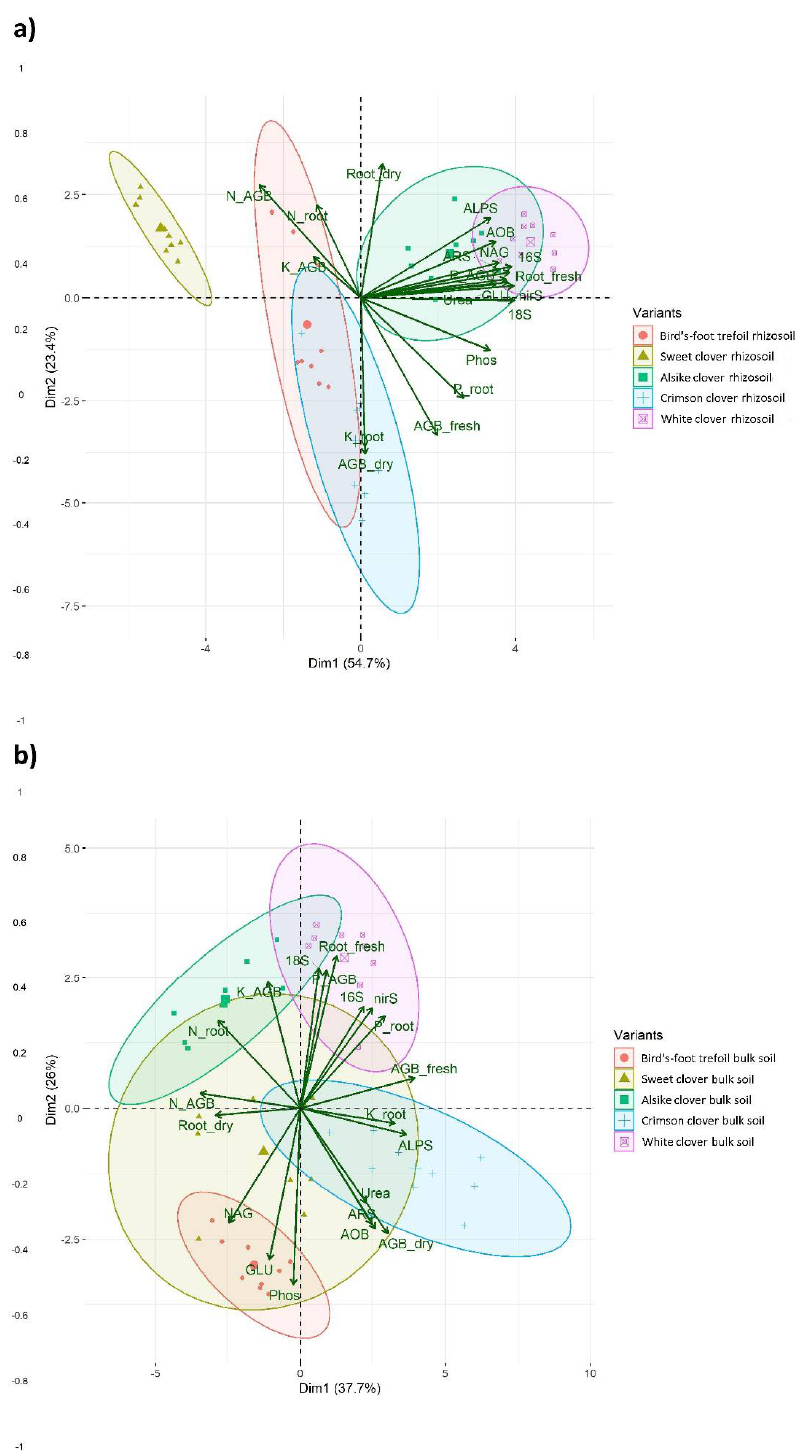
Figure A1. PCA biplot analyses of the properties of rhizosoil ( a ) and bulk soil ( b ) and plant biomass. Abbreviations are: (AGB-fresh, dry); fresh and dry aboveground biomass, (root-fresh, dry); fresh and dry root biomass, (N-, P-, K- AGB or root); biomass nutrient (N,P,K) in AGB or roots, (16S, 18S, AOB, NirS , ALPS); bacterial, fungal, ammonium oxidizing bacteria, denitrifying bacteria and phosphorus solubilizing bacteria and (Glu, ARS, Phos, NAG, Ure); β -glucosidase, arylsulfatase, phosphatase, N-acetyl- β -D-glucosaminidase, and urease enzymes,